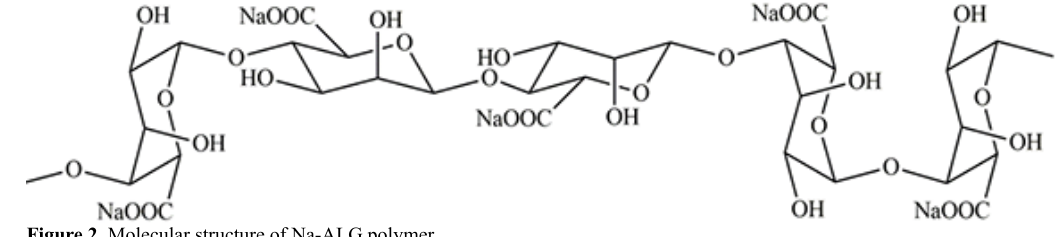
Figure 2. Molecular structure of Na-ALG polymer.